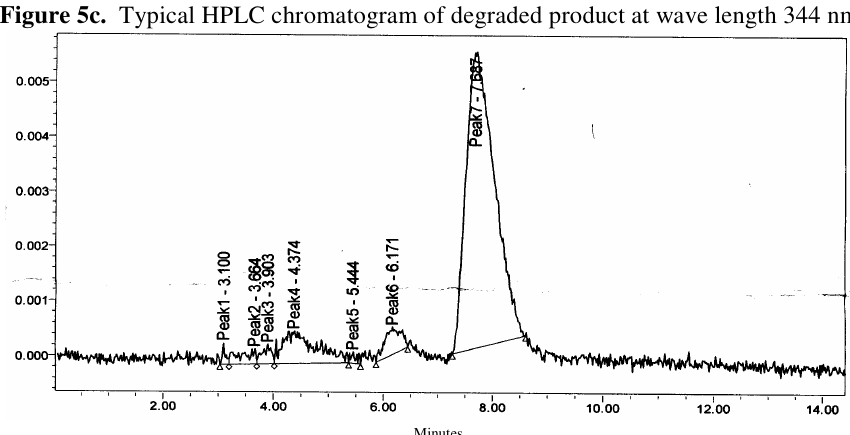
Figure 5d. Typical HPLC chromatogram of degraded product at wave length 380